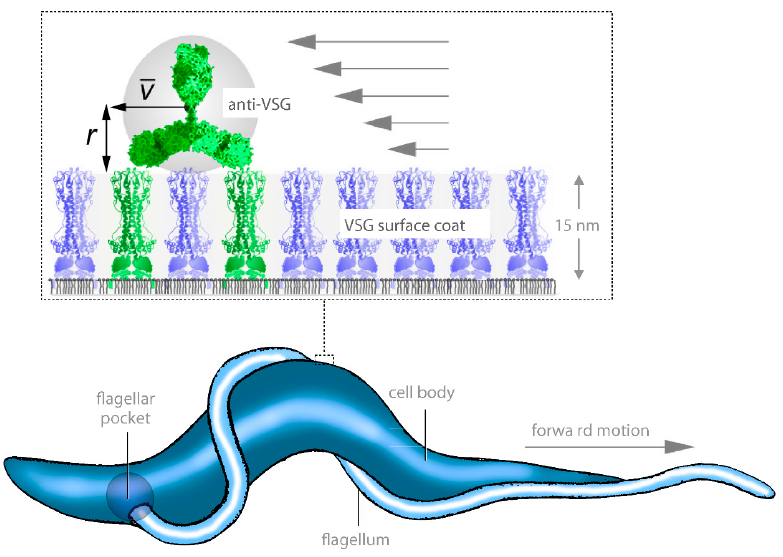
Figure 3. Hydrodynamic antibody clearance. The concerted action of cell motility and localised endocytosis is responsible for antibody clearance: As a single type of variant surface glycoprotein (VSG) covers the complete trypanosome cell body, the host immune response is directed specifically against this surface coat. VSGs are Glycosylphosphatidylinositol (GPI)-proteins that are specifically anchored to the outer leaflet of the plasma membrane. This lipid-modification makes VSGs highly mobile proteins; they diffuse freely and rapidly in the membrane. Antibodies that bind to VSG (green) extend above the unusually smooth surface coat and are dragged by hydrodynamic flow towards the posterior part of the cell, where the very efficient endocytosis machinery resides. The hydrodynamic drag acting on the VSG-bound antibodies originates from the constant and directional puller-type motion of the